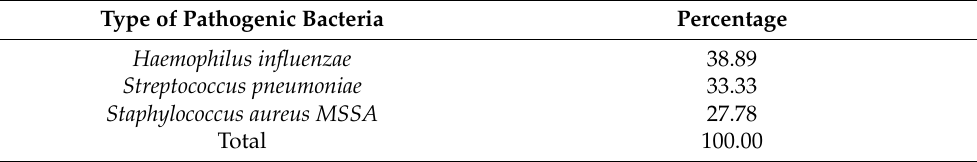
Table 6. Type and percentage of pathogenic bacteria in exudate collected from the middle ear space.